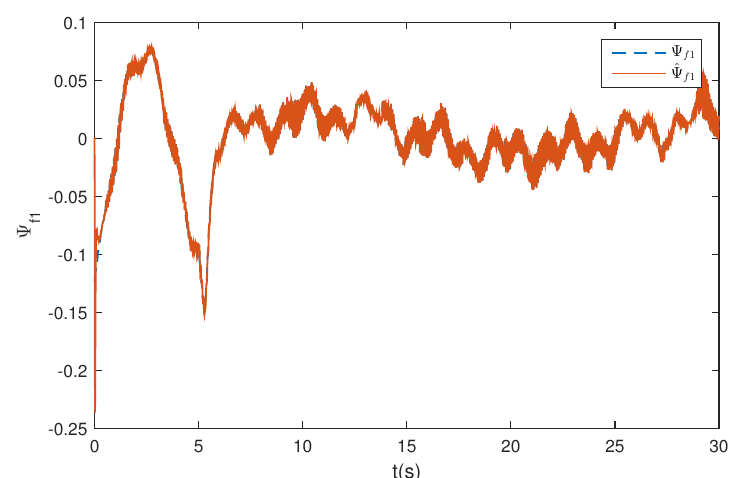
Figure 25. Estimation of Ψ f 1 under